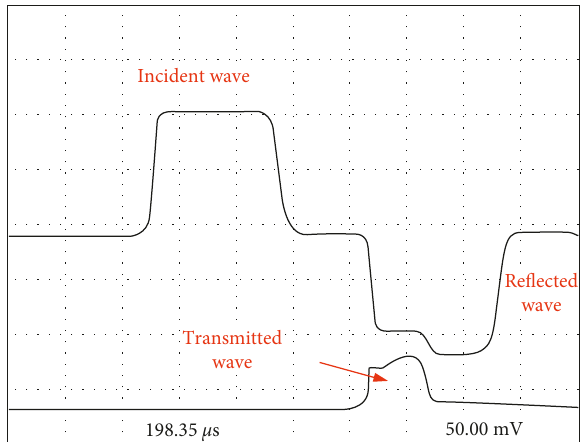
Figure 11: Typical three wave signals of the TSHB experiment